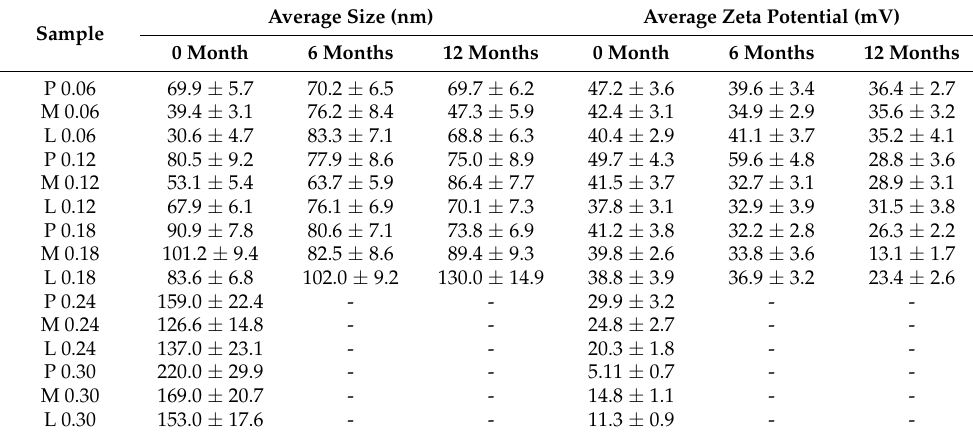
Table 4. The characterization of AuNPs in aqueous solutions: the average size and zeta potential of nanoparticles over time. The values are expressed as mean ± standard